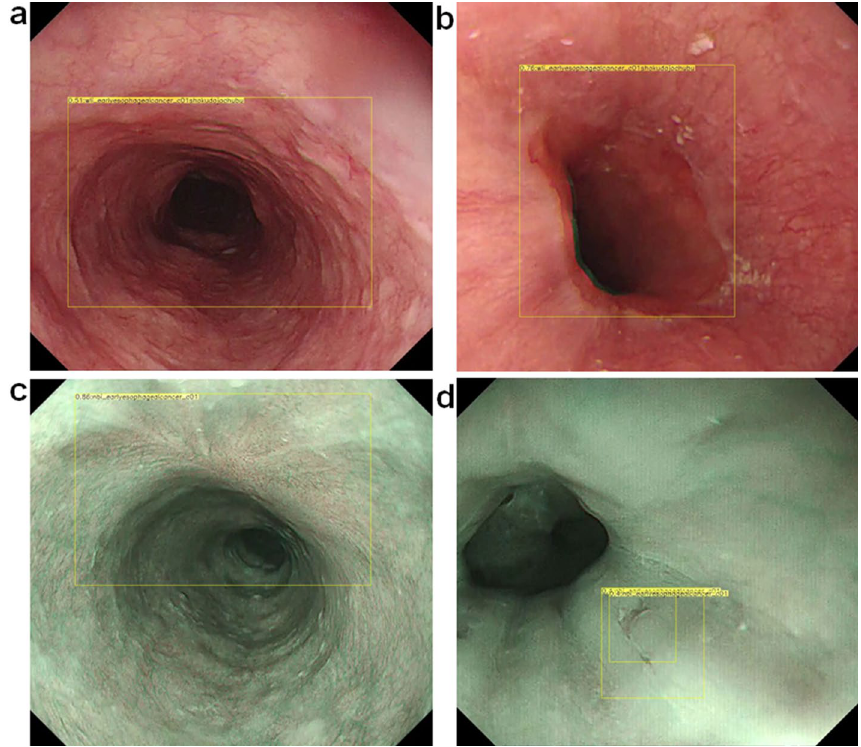
Figure 3. Examples of false-positive images. The yellow squares indicate areas that were misdiagnosed as cancer. ( a ) shadow of lumen, ( b ) EGJ, ( c ) post ER scar, ( d ) inflammation. ER: endoscopic resection, EGJ: esophagogastric